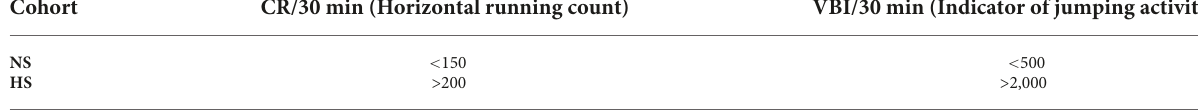
TABLE 2 30-min cut-off values for the classification of NS and HS running and jumping activity. Cohort CR/30 min (Horizontal running count) VBI/30 min (Indicator of jumping activity) NS < 150 < 500 HS >200 >2,000